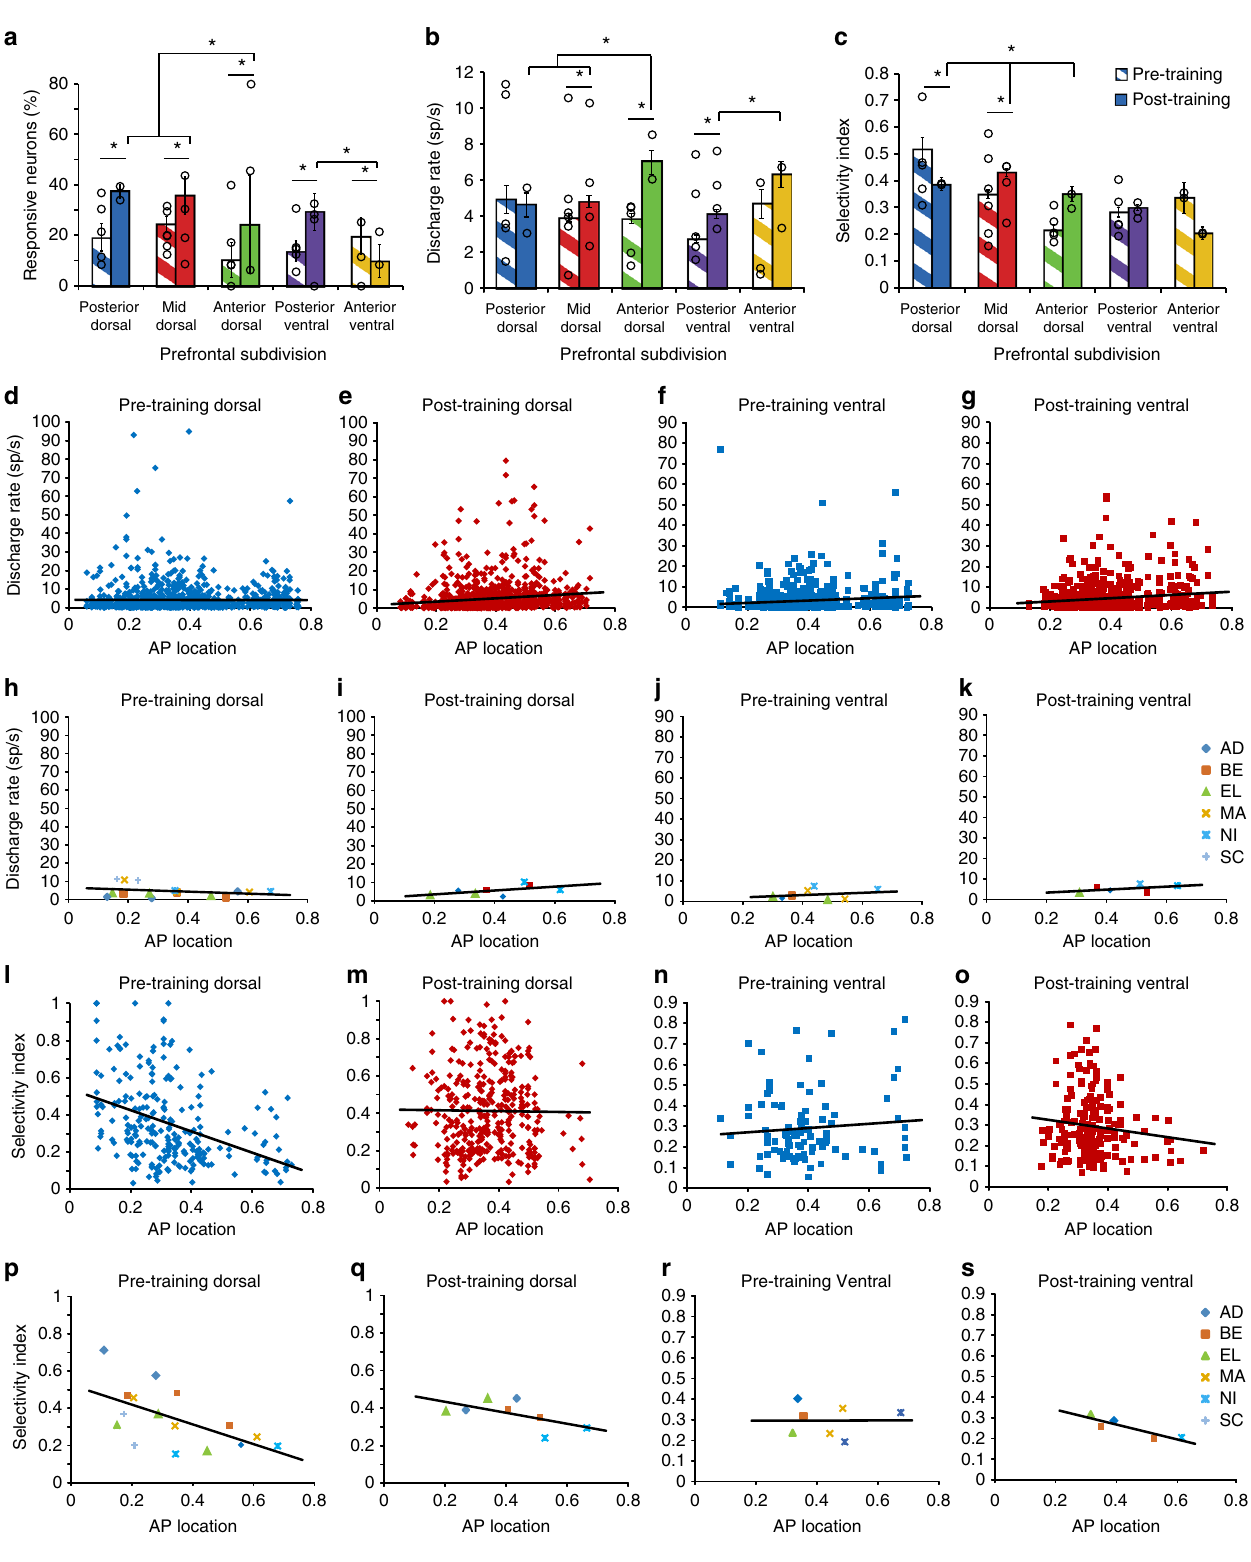
signi fi cant (F 1,1082 = 17.83, r = 0.179, p = 2.6 × 10 − 5 ), as was the increase of the post-training slope relative to the pre-training one (F-test, F 1,2288 = 15.31, p = 0.0001). Among ventral regions (Fig. 3b, f, g), increases in fi ring rate were also greater in the anterior than the posterior division after training. Increases in activity were not exclusive to the delay period; cue responses